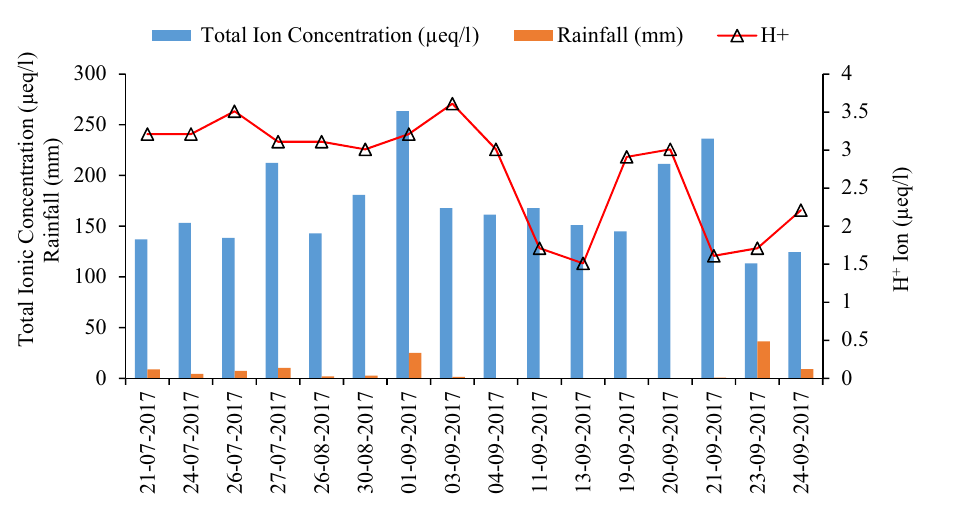
Figure 4. Average seasonal H + ion variations, rainfall amount, and ion